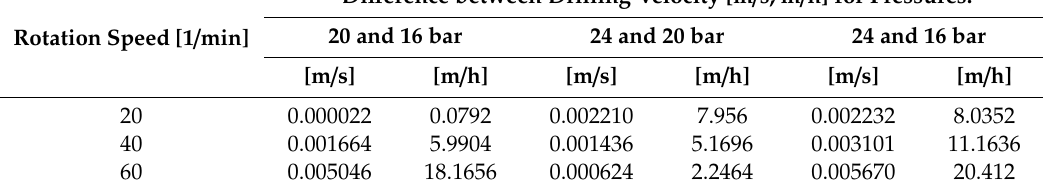
Table 8. Di ff erences between drilling velocity measured for various air pressures and drill rotation speeds of the 140 mm diameter drill bit, in the interval 72–90 m below ground level.